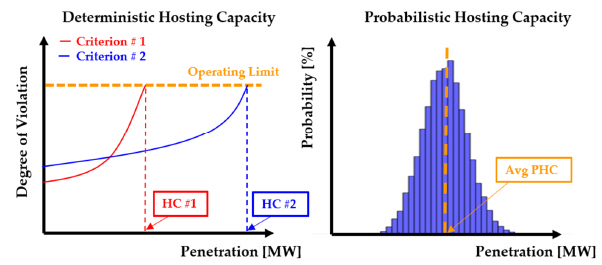
Figure 1. Concept of deterministic and probabilistic hosting capacity.